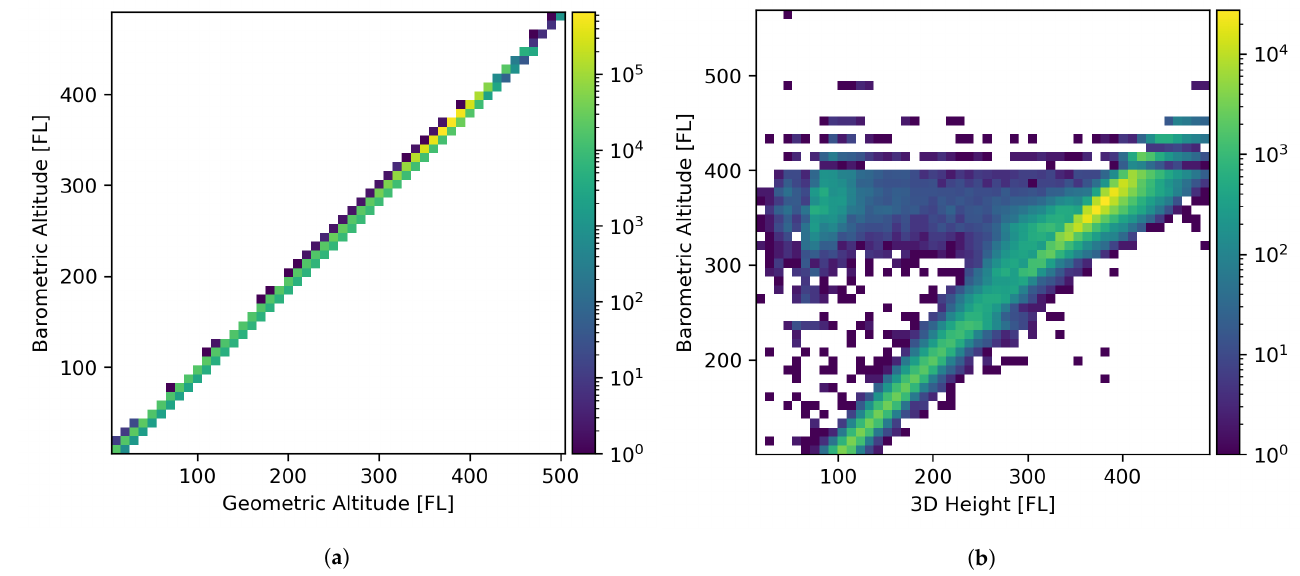
Figure 2. Barometric/Geometric Altitudes. ( a ) From ADS-B. ( b ) From Radar. The chosen method was to approximate the p 0 , t 0 , α parameters using barometric/ geometric altitude pairs based on (reliable) ADS-B data (see Section 4.2.1). This approach allows the usage of standard formulas, physical interpretations of the model parameters, and comparisons to real-life meteorological